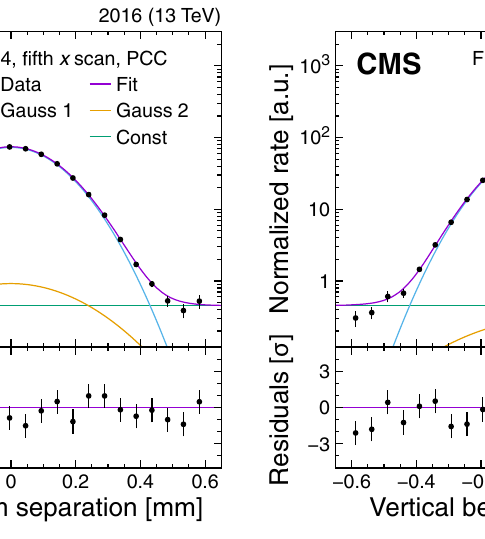
Fig. 4 Example vdM scans for PCC for BCID 41, from the last scan pair in fill 4954, showing the rate normalized by the product of beam currents and its statistical uncertainty as a function of the beam sepa- ration in the x (left) and y (right) direction, and the fitted curves. The purple curve shows the overall double-Gaussian fit, while the blue, yel- Fig. 5 The two figures show comparisons of effective area ( A eff ) of cross-check luminometers with respect to the nominal PCC+PVC for fills 4266 (upper) and 4954